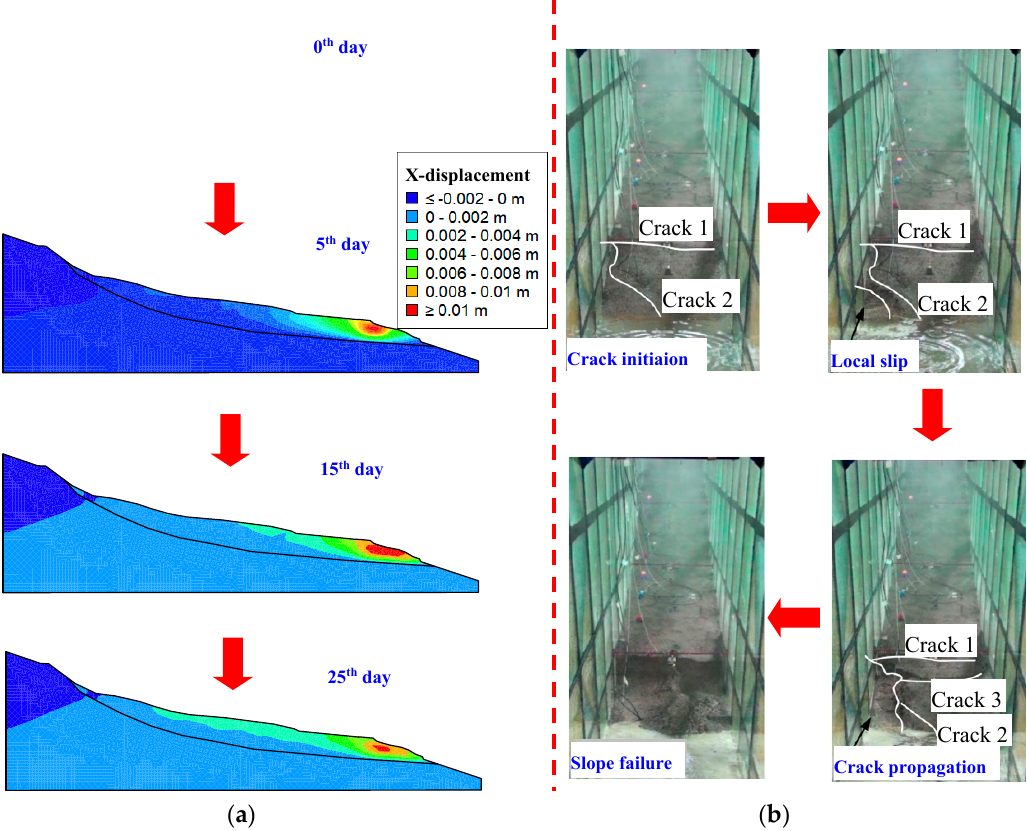
Figure 15. Comparison between our numerical simulation results and test results in reference [48]. ( a ) Numerical simulation results in this paper. ( b ) Test results in reference [48].